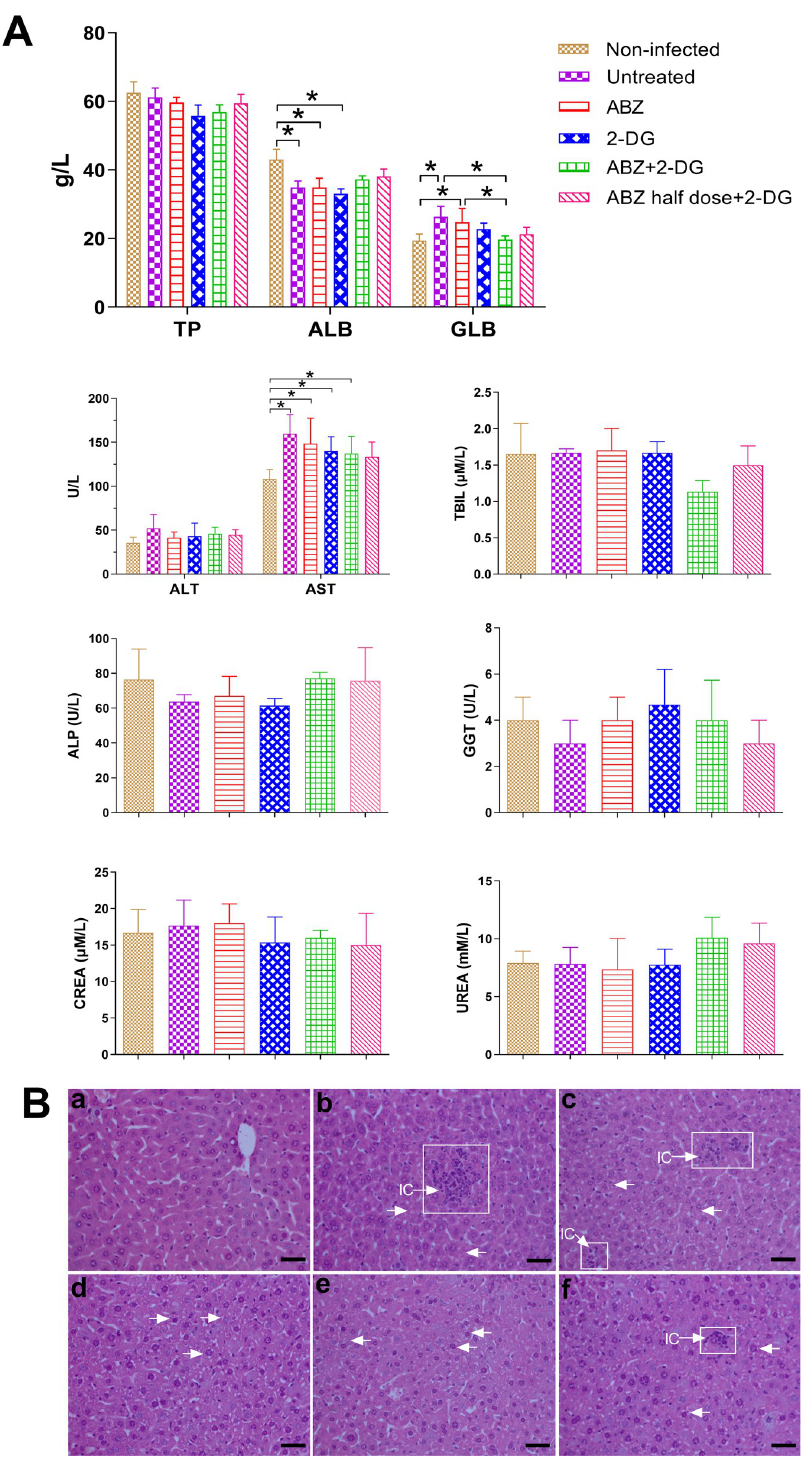
Fig 6. Serum biochemical analysis and histopathological examination in mice treated with ABZ, 2-DG, ABZ + 2-DG, or ABZ half-dose + 2-DG for 6 weeks. (A) The levels of total protein (TP), albumin (ALB), globulin (GLB), alanine aminotransferase (ALT), aspartate aminotransferase (AST), total bilirubin (TBIL), alkaline phosphatase (ALP), glutamyltranspeptidase (GGT), urea, and creatinine (CREA) in mice serum. � p < 0.05. (B) H&E images of liver tissues. Non-infected tissue (a), E . multilocularis- infected tissue (b), ABZ-treated tissue (c), 2-DG-treated tissue (d),